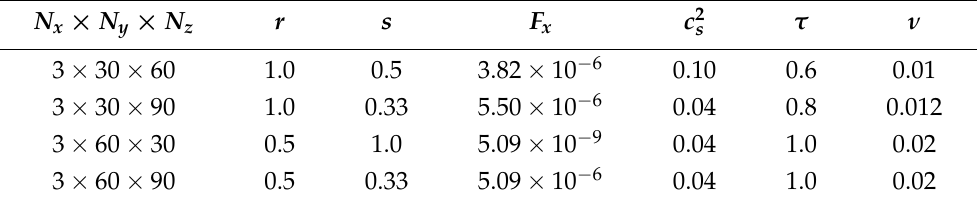
Table 1. Parameters used in the simulations of 3D square duct flow using 3DCCM-LBM at different lattice grid aspect ratios with a constant Reynolds number Re = 50.